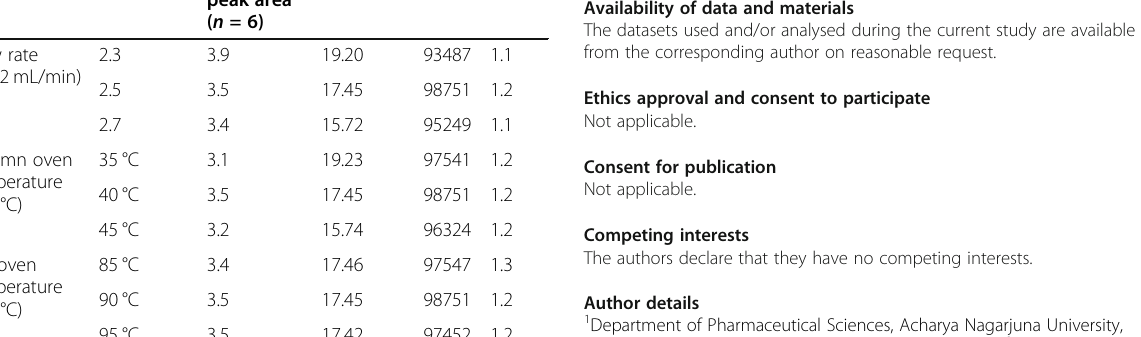
Retention Plate Tailing time count factor